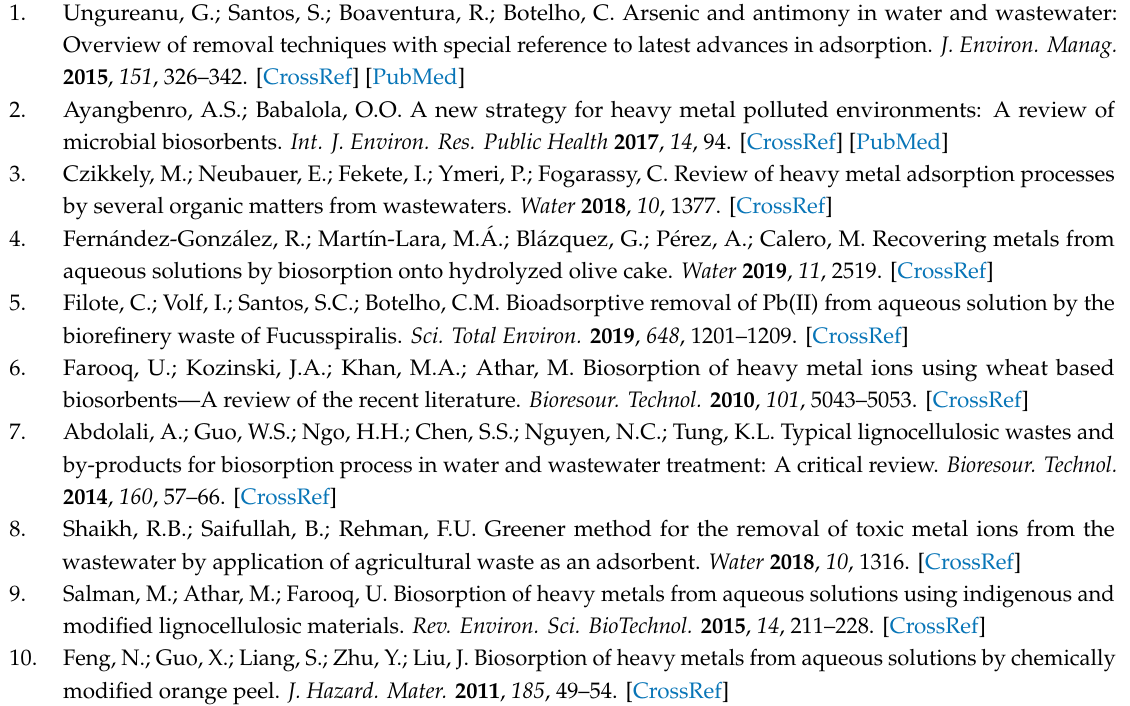
Figure S1: Change of the quantity of Pb adsorbed ( Q t ) by the biosorbents with the contact time (t), Figure S2: Change of the quantity of Pb adsorbed after equilibrium ( Q e ) with the initial pH, Figure S3: Change of the quantity of Pb adsorbed after equilibrium ( Q e ) with the initial concentration ( C 0 ), and Table S1: Parameters obtained by fitting the kinetic data (in Figure S1) with the pseudo-second order